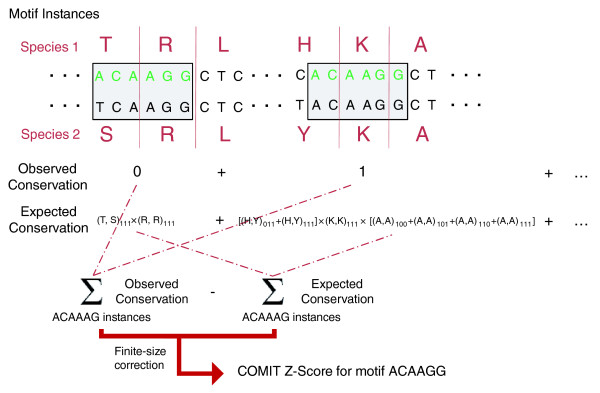
Schematic of the COMIT algorithm for identifying unusually conserved motifs in coding regions. The example illustrates how the score would be calculated for the motif ACAAAG, using genome-wide coding sequence alignments for two species. Each instance of the motif is identified in species 1, and the observed conservation - that is, whether all bases are identical among the two species - is calculated. The expected conservation at each instance is modeled from genome-wide frequencies of nucleotide-level conservation patterns conditional on the aligned amino acids. For each instance, the expected conservation is calculated from all possible ways in which the motif could be conserved at that location given the amino acids in each species, using values from Table 1 (typically some of these quantities, such as (H, Y)111, will be zero). The observed and expected conservation levels are compared and normalized to yield a conservation z-score for each motif.